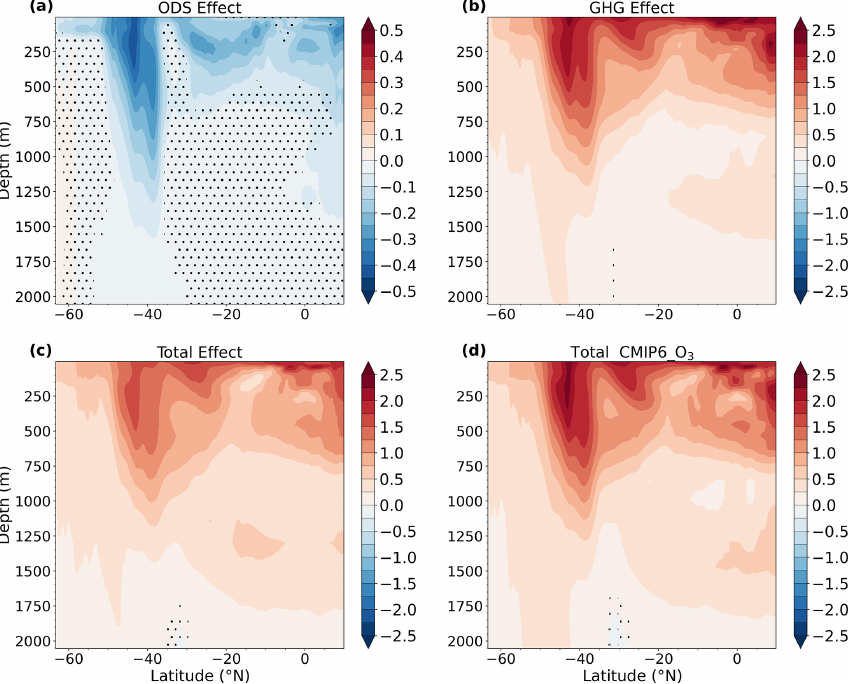
Figure 18. Latitude–depth profile of oceanic potential temperature changes ( ◦ C) zonally averaged over the high-resolution nest (70 ◦ W– 70 ◦ E): effect of ozone recovery (a) , effect of GHGs (b) , total effect in INTERACT_O 3 (c) , and total effect in CMIP6_O 3 (d) . The stippling masks regions where the changes are not significant at the 95% confidence interval based on a two-tailed t